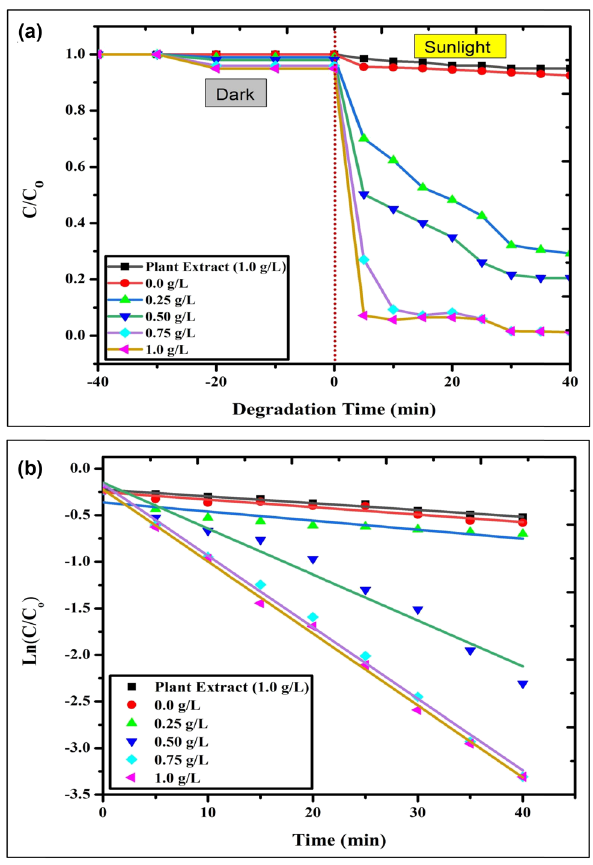
Figure 12: Photo removal ( a ) and kinetics ( b ) of phyto - fabricated ZnO NPs from S. acuta .